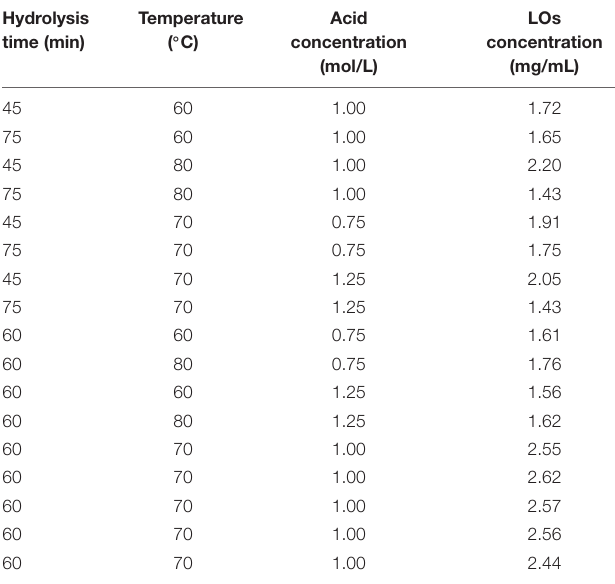
TABLE 1 | The box Behnken design with three independent variables, include hydrolysis time, temperature, and acid concentration for the LOs production. Hydrolysis time (min)